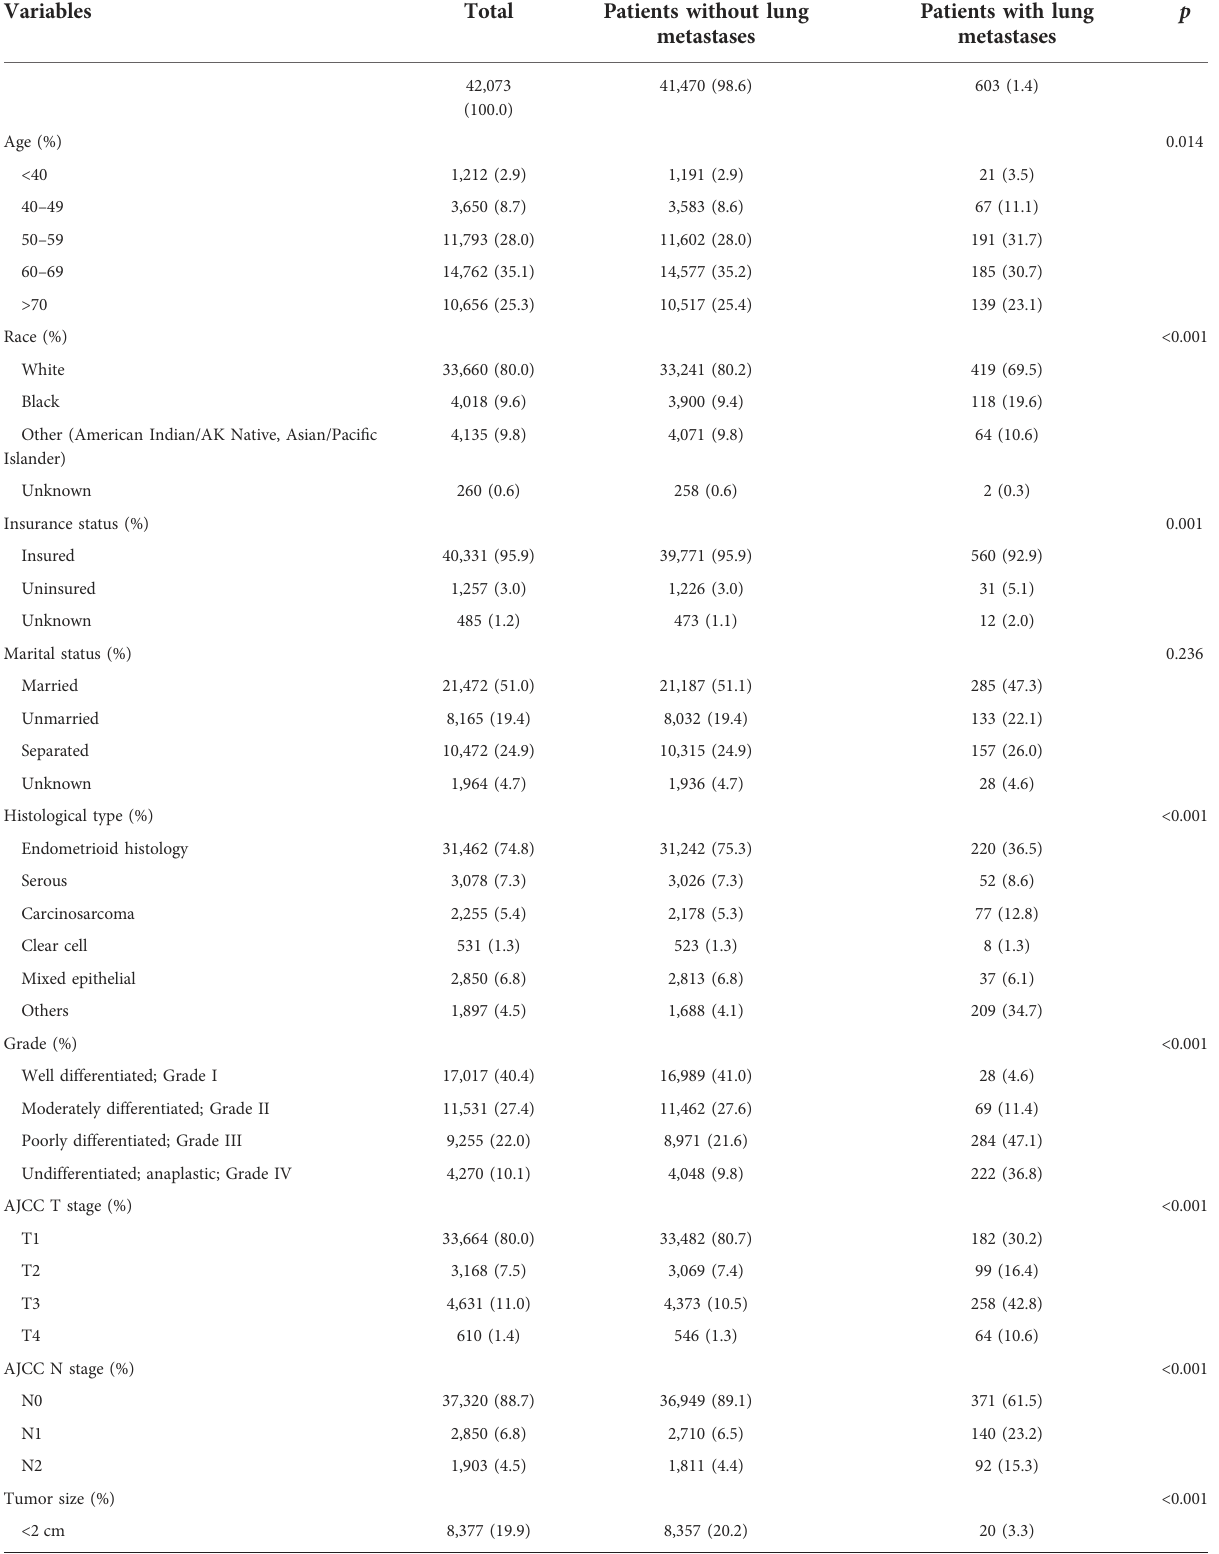
TABLE 1 Demographical and clinical characteristics between endometrial carcinoma patient with the lung metastases and without the lung